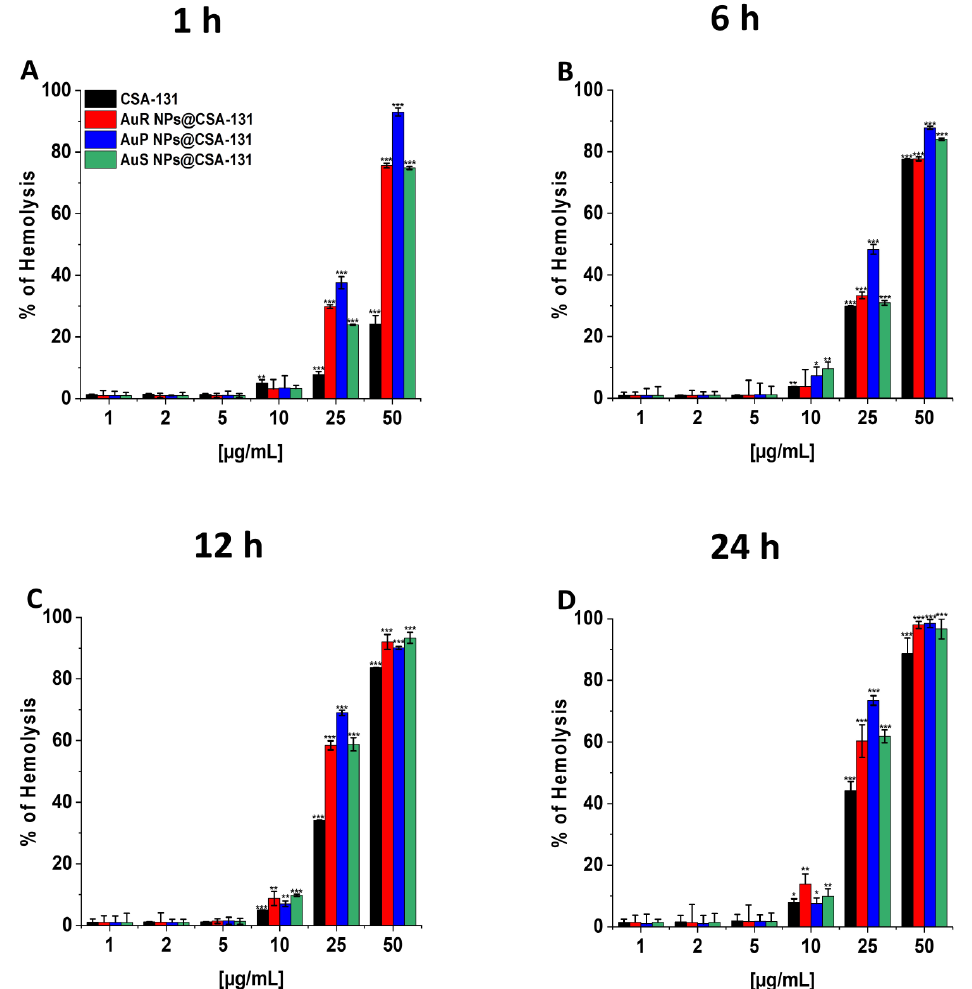
Figure 8. Hemoglobin release from human red blood cells (RBCs) incubated in the presence of AuR NPs@CSA-131, AuP NP@CSA-131, AuS NP@CSA-131, and CSA-131 ( A–D ) at doses of 1–50 µg/mL after 1 h ( A ), 6 h ( B ), 12 h ( C ), and 24 h ( D ). Results show the mean ± SD, n=3; * indicates statistical significance at p ≤ 0.05, ** ≤ 0.01 and *** ≤ 0.001.